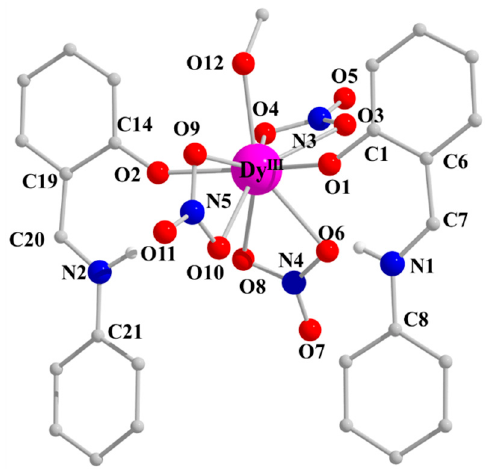
Figure 4. Partially labelled plot of the structure of the molecule [Dy(NO 3 ) 3 (salanH) 2 (MeOH)] that is present in the crystal structure of complex 18 _Dy.